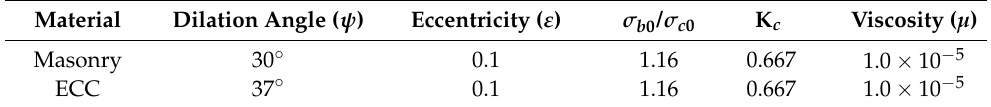
Table 4. Plastic properties of the homogenized brick wall and the ECC material used in this